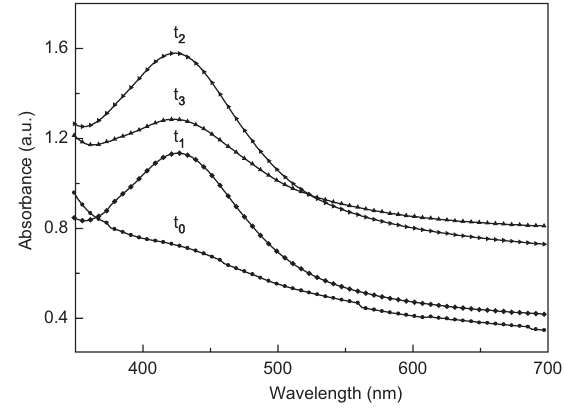
Figure 4 Temporal evolution of the Ag(acac)/PS fi lm optical